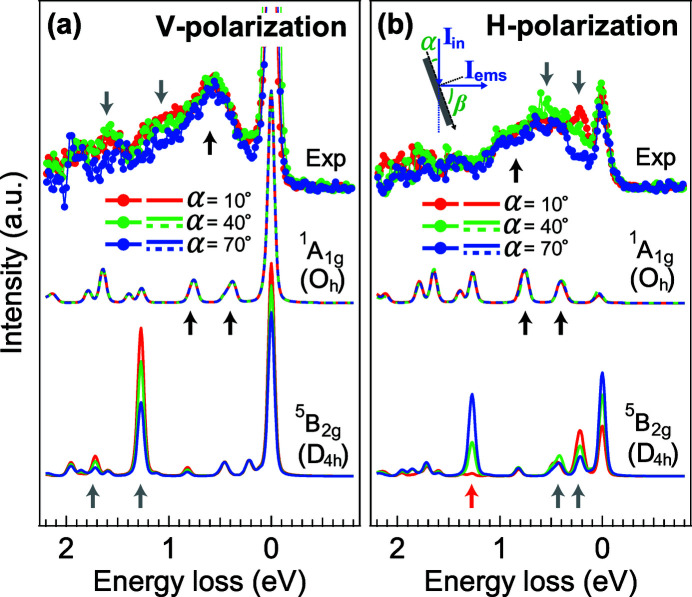
The 2p3d RIXS results of the 55 nm LaCoO3/SrTiO3 film compared with the 1A1g(Oh) and 5B2g(D4h) ground states. Both the (a) V- and (b) H-polarized are calculated and measured at a geometry for a scattering angle of 90°.